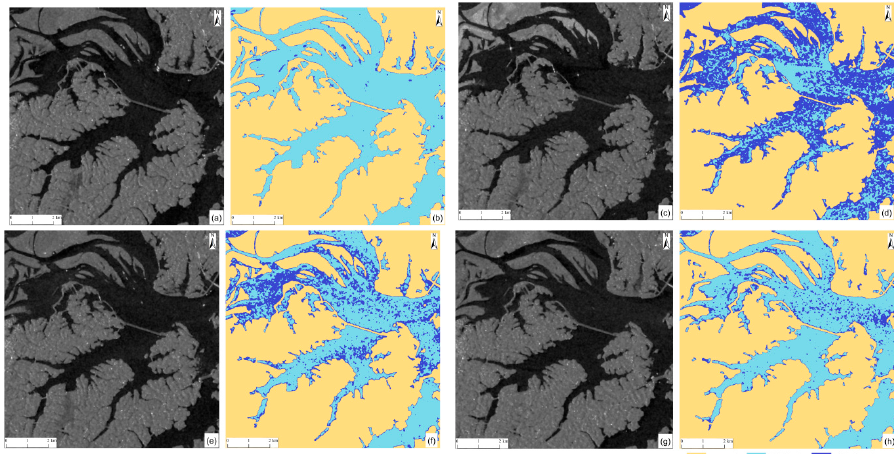
Figure 4. The initial water contours using tile-based KI thresholding method, refined water contours by ACM model, and final extracted water inundations for validation site B; ( a ), ( c ), ( e ), and ( g ) show the initial and refined water contours, as well as the Sentinel-1 scene in VV polarization acquired on 23 May 2017, 22 July 2017, 20 September 2017, and 9 October 2018, respectively; ( b ), ( d ), ( f ), and ( h ) show the corresponding final water and non-water classification.